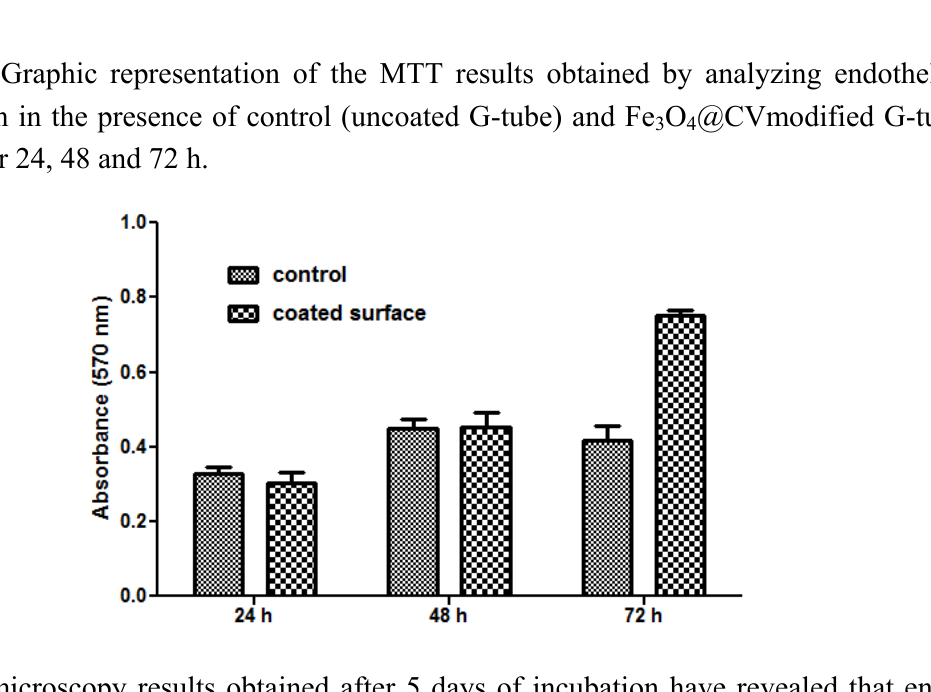
O @CVmodified G-tube 3 4